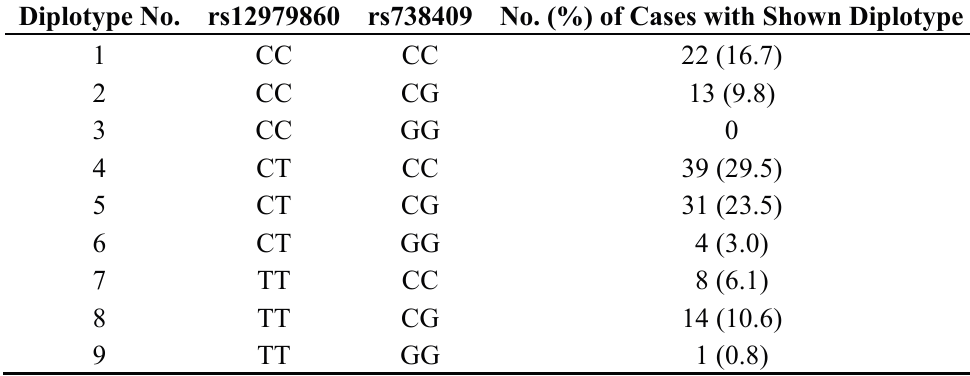
Table 2. Distribution of diplotypes according to rs12979860 and rs738409 in the studied